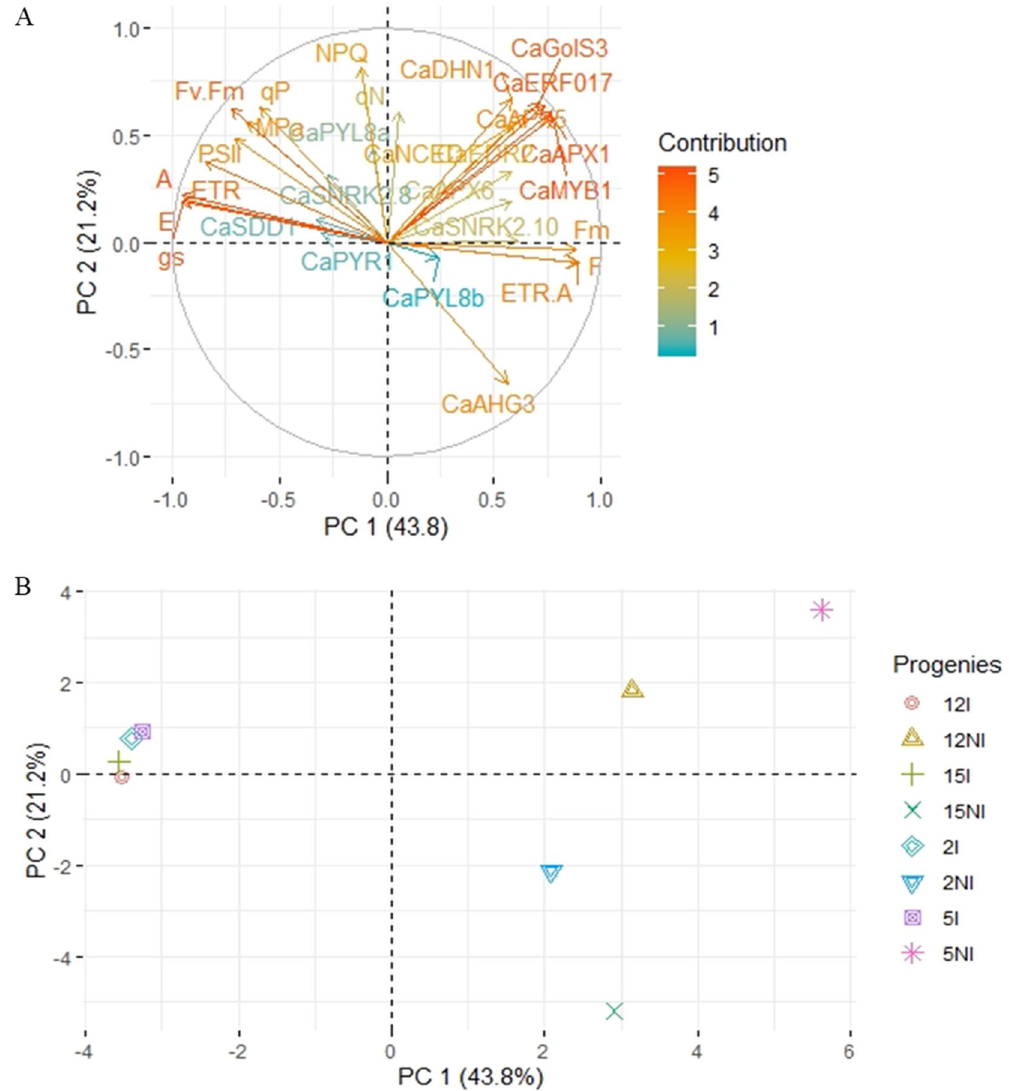
Figure 3. The first two axes of a PCA of all 4 irrigated (I) and non-irrigated (NI) progenies. The size of the vectors (arrows) represents the correlation between variable and PC. The plots show the contribution of the physiological characteristics and several gene expression profile ( A ) and segregation scores of each progeny under irrigated and non-irrigated conditions ( B ) for the first two principal